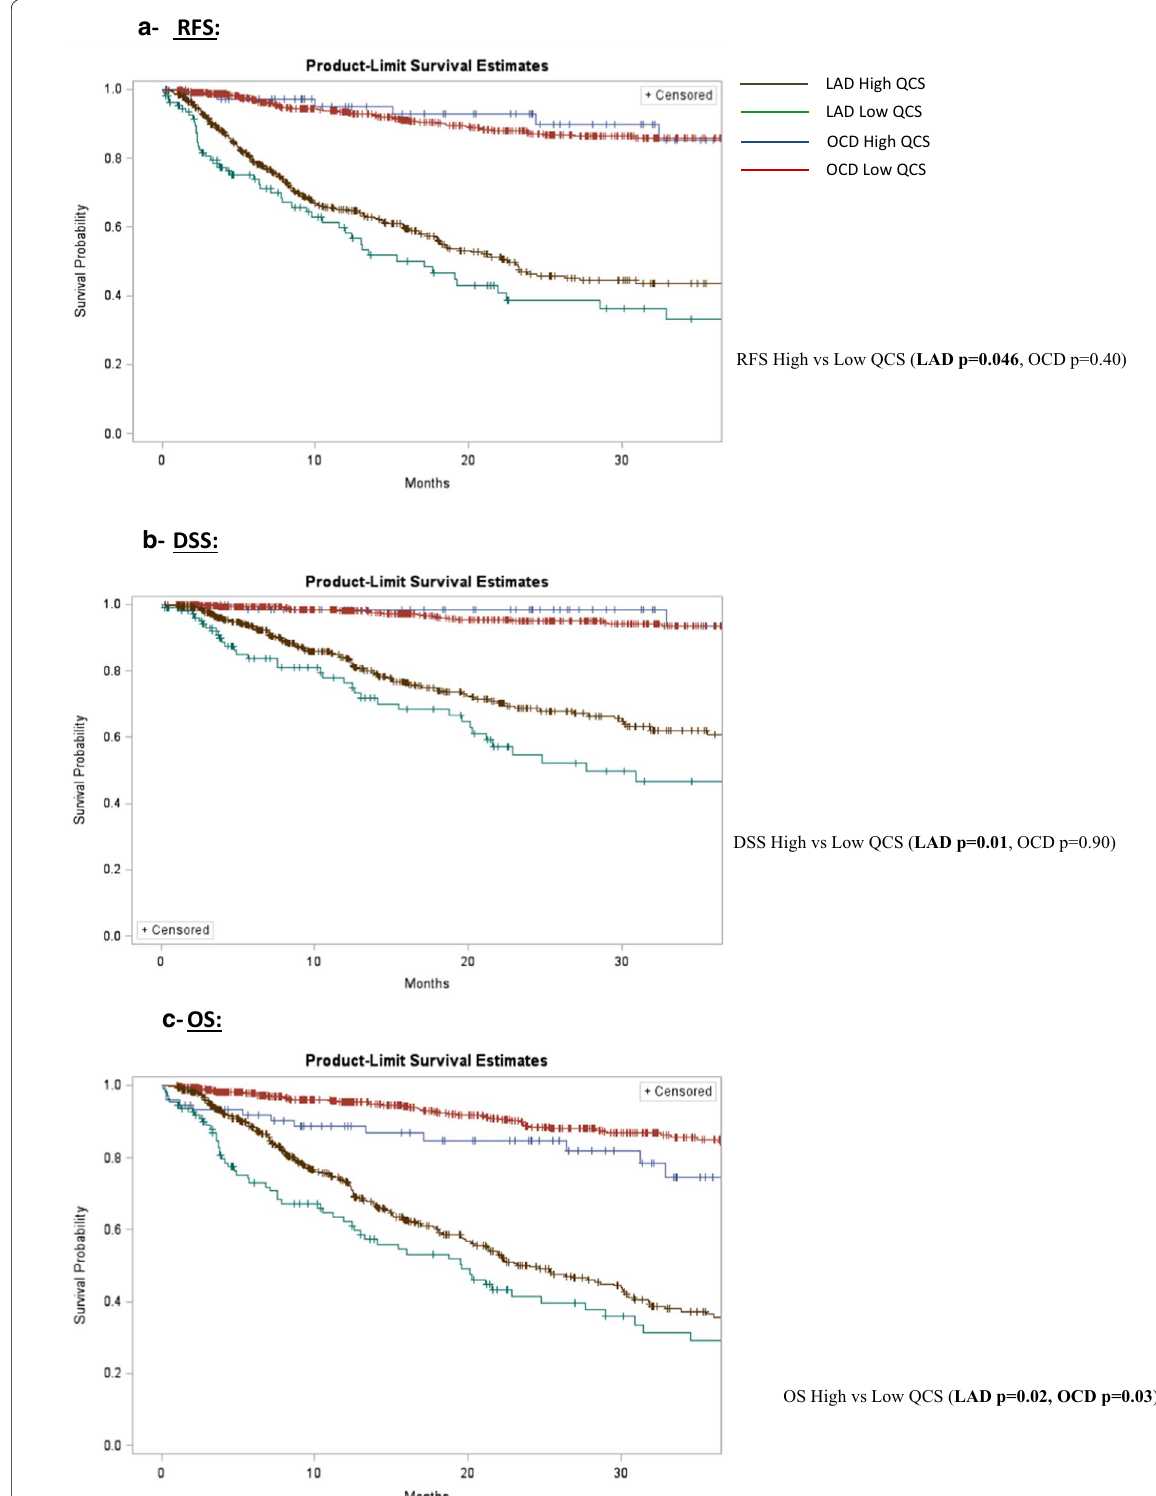
Fig. 3 Kaplan–Meier curves for RFS, DSS and OS for patients with OCD versus LAD stratified by QCS score (high QCS vs. low